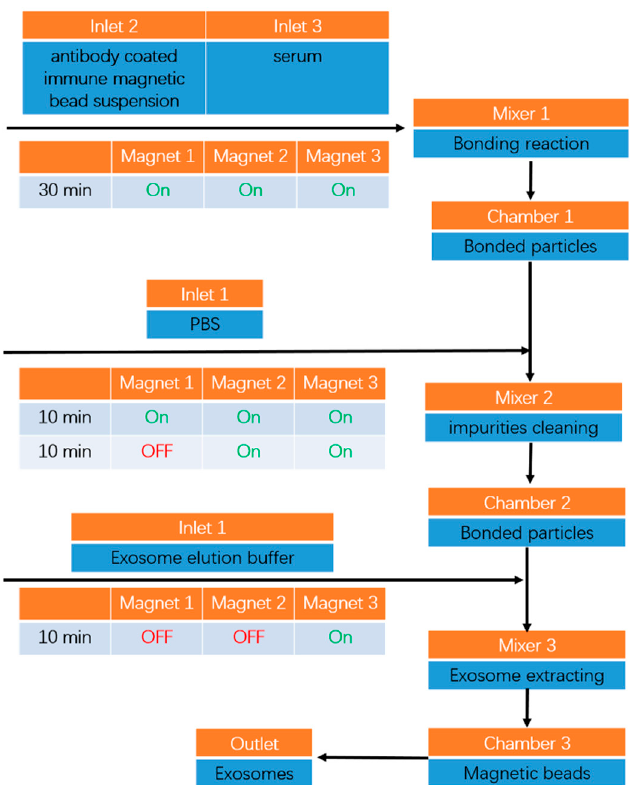
Figure 9. Processing flow chart of exosomes isolation using the designed microfluidic chip. The green “on” represents the magnet corresponding to i th chamber, and the red “off” is moved off. The times indicate that this step of the operation should last for that long. The blue blocks indicate the relevant substances enriched or the procedures that occurred within the corresponding substructures (marked with orange above each blue block) of the microfluidic chip.